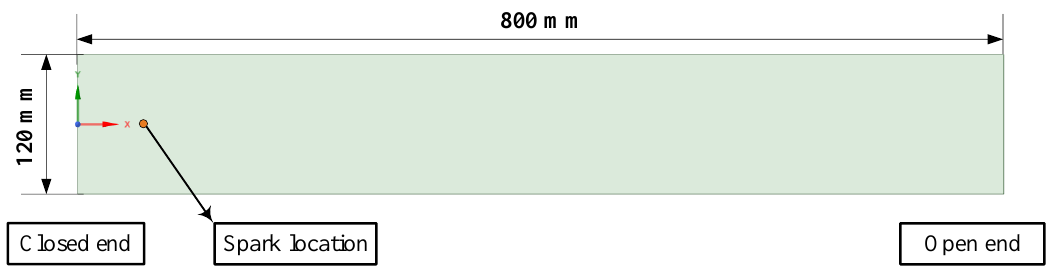
Figure 1. Geometry of the 2D channel. Table 2. Parameters for the ignition model.